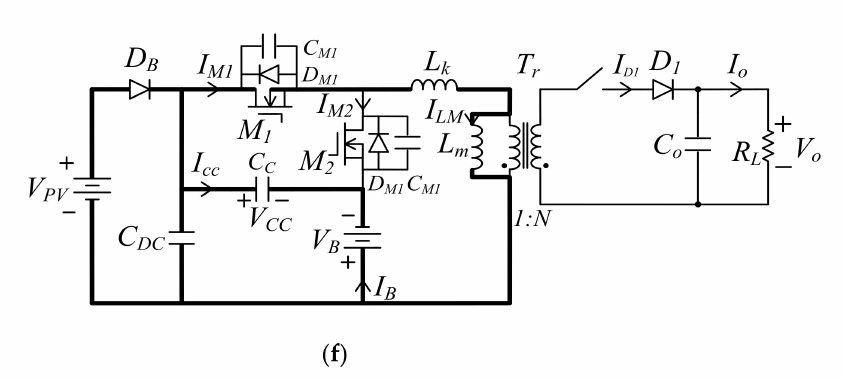
Figure 9. Equivalent circuit of the proposed hybrid converter operated in the charging mode over one switching cycle; ( a ) Mode 1 ( t 0 ≤ t < t 1 ); ( b ) Mode 2 ( t 1 ≤ t < t 2 ); ( c ) Mode 3 ( t 2 ≤ t < t 3 ); ( d ) Mode 4 ( t 3 ≤ t < t 4 ); ( e ) Mode 5 ( t 4 ≤ t < t 5 ); ( f ) Mode 6 ( t 5 ≤ t < t 6